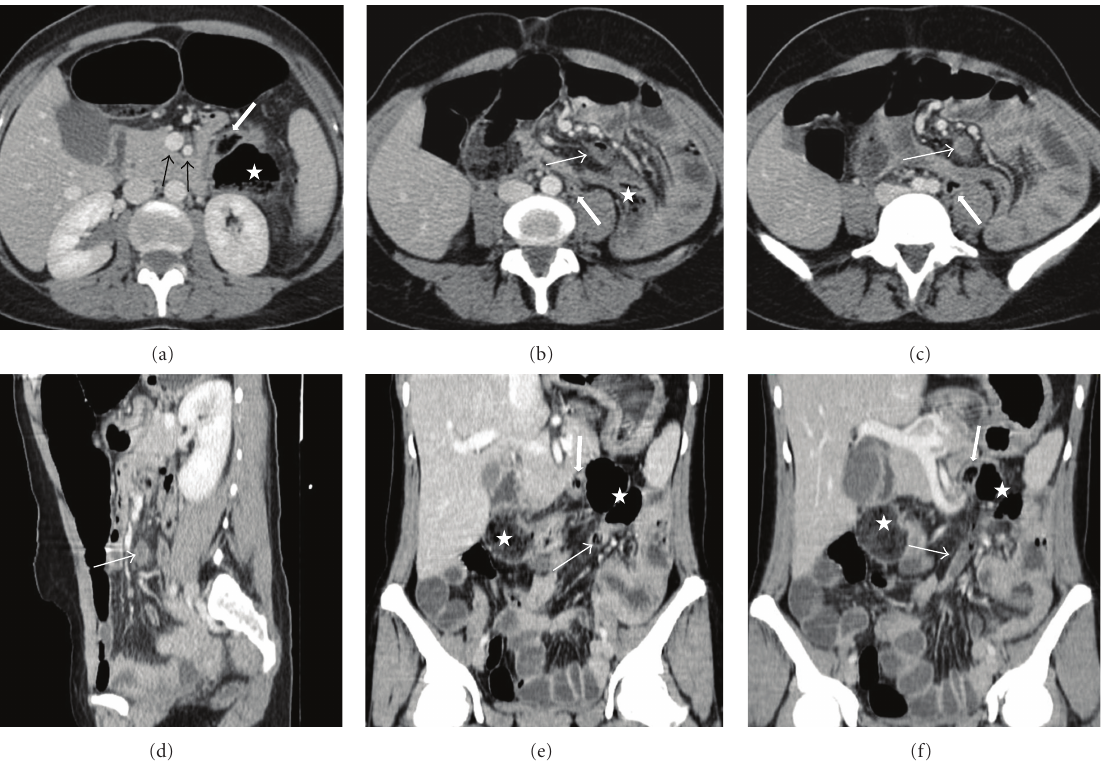
Figure 1: Axial (a–c), sagital (d) and coronal (e, f) CT images demonstrate absence of caecum and right hemicolon in the right side of abdomen. Normal position of superior mesenteric artery and vein (black arrows), so intestinal malrotation was excluded (a). Caecum and right hemicolon (star) located in the left upper quadrant adjacent to splenic flexure and descending colon (white closed arrows). CT images demonstrate 15 mm diameter tubular structure consistent with appendicitis located posteroinferior to the caecum, extending inferomedially to the umbilicus (white open